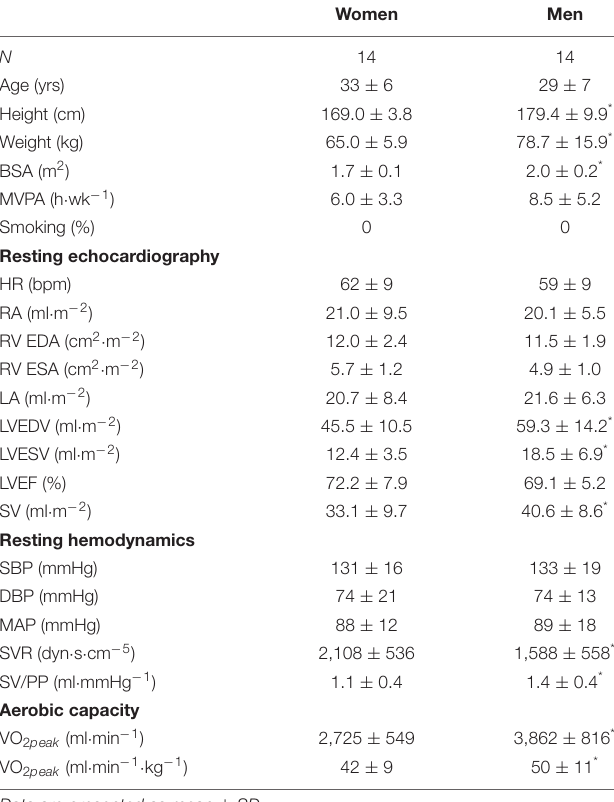
Table 1 present main baseline characteristics of the study subjects. Women had smaller anthropometric indices (height, weight, TABLE 1 | Baseline characteristics of study subjects.